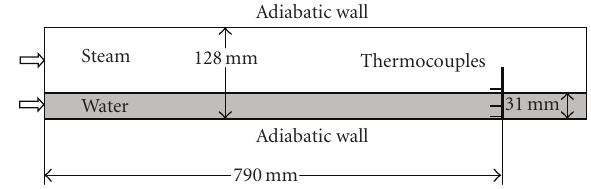
Figure 7: 2D simulation